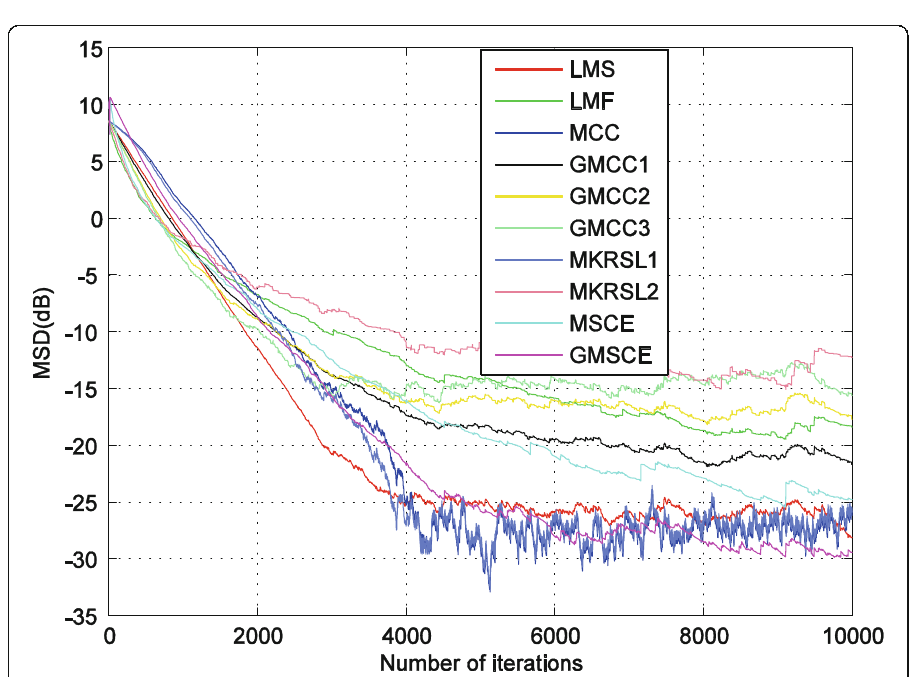
Fig. 6 Comparisons of the algorithms under super-Gaussian noise shown in Fig.